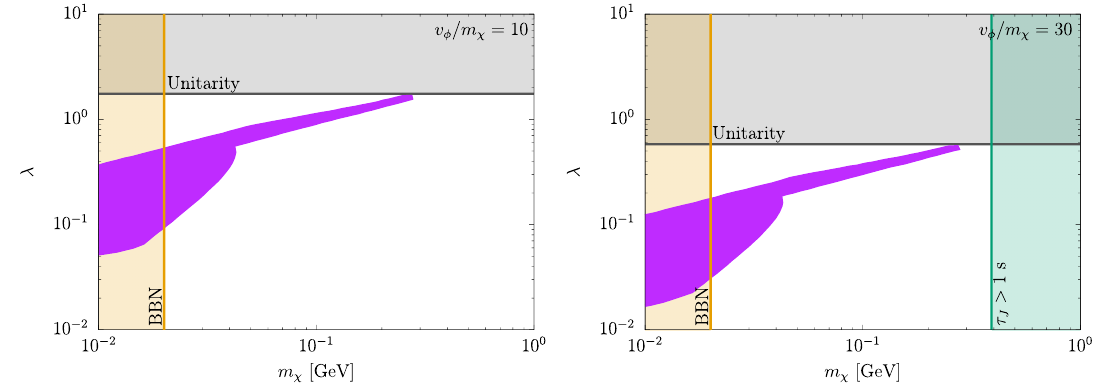
Figure 5 . Parameter space in the ( m χ , λ ) plane where the Majoron mass is fixed to be m J /m χ = 3 . The purple region can reproduce the observed relic abundance and form dark matter cores via strongly self-interacting dark matter. ( 0 . 1 cm 2 / g ≤ σ self /m χ ≤ 1 cm 2 / g ). The gray region is excluded by the unitarity bound for the quartic coupling λ , and the other colored regions are the same as in figure